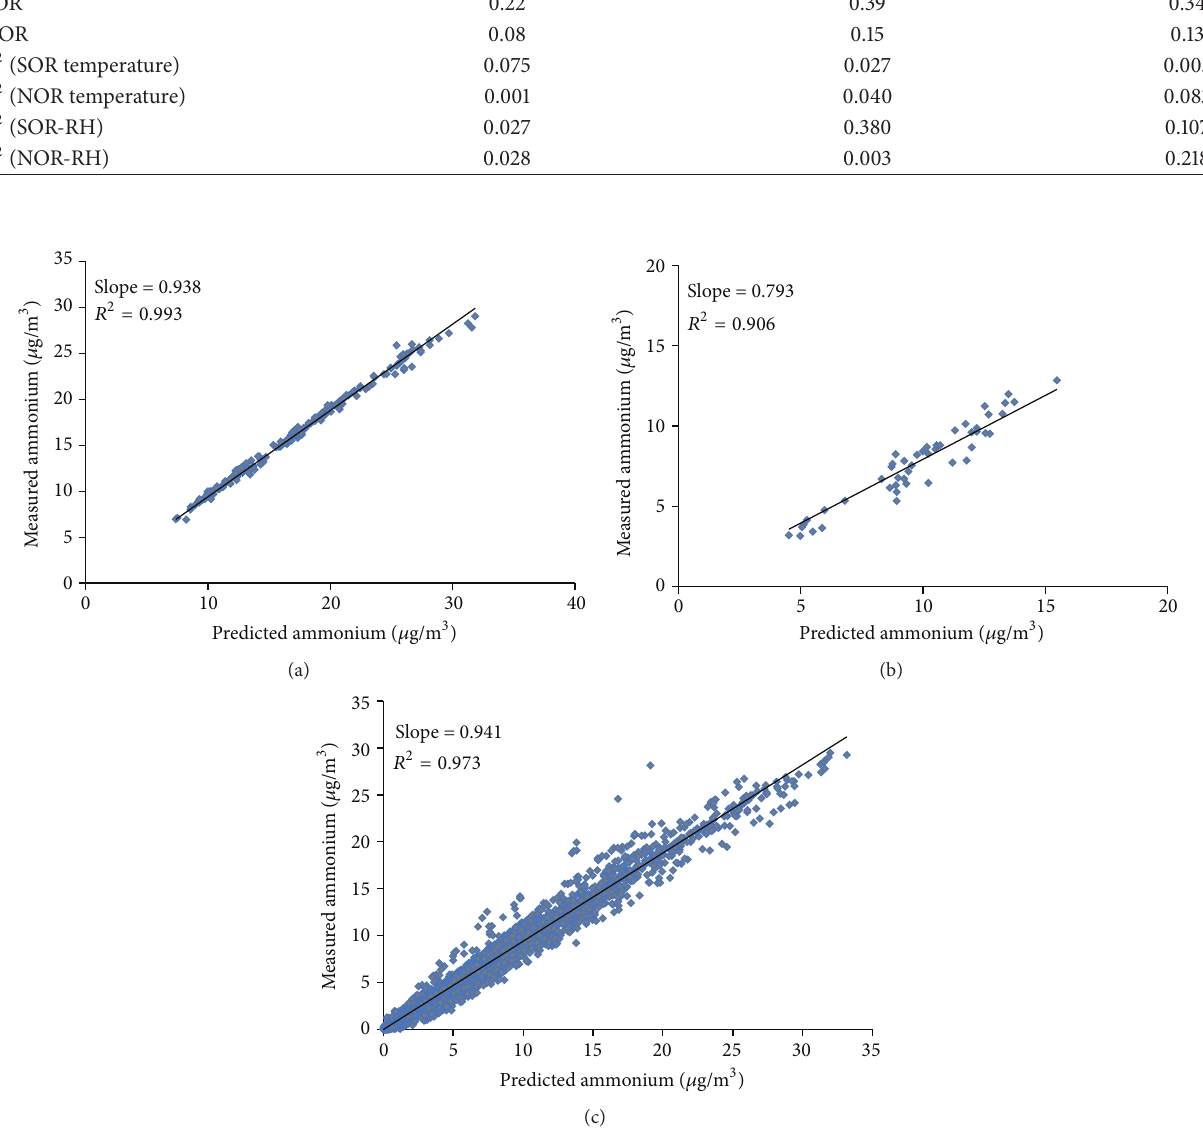
Figure 6: Correlation between measured ammonium and predicted ammonium. (a) Case 1 , (b) Case 2 , and (c) annual